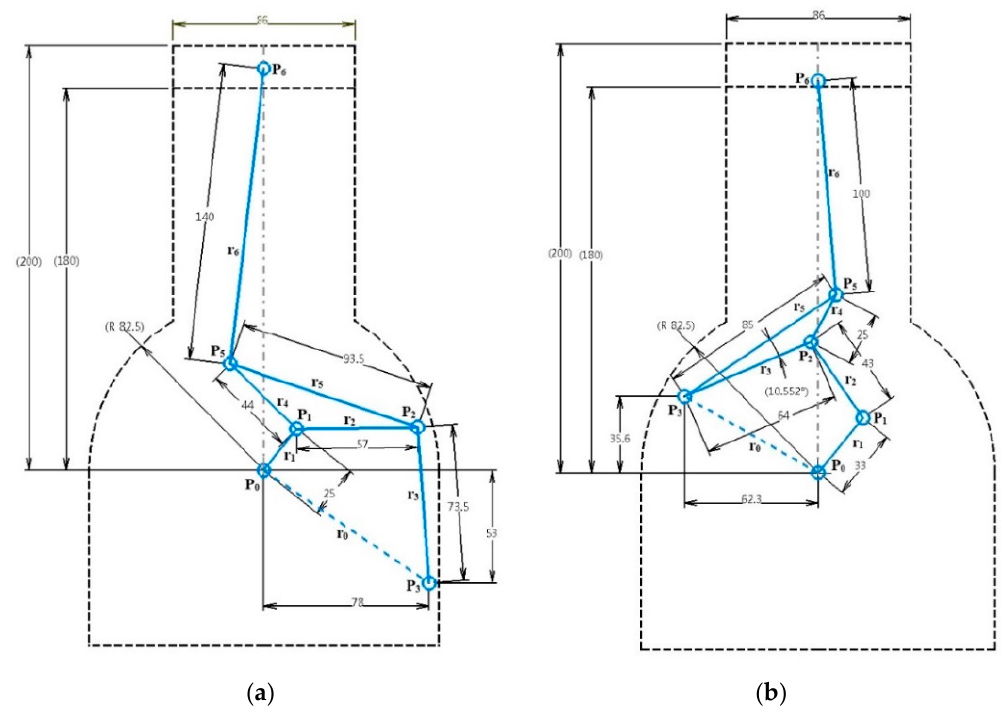
Figure 3. Initial design of VCR engine mechanisms: ( a ) Stephenson III and ( b ) Watt II. Table 4. Analysis results of the initially designed mechanisms.